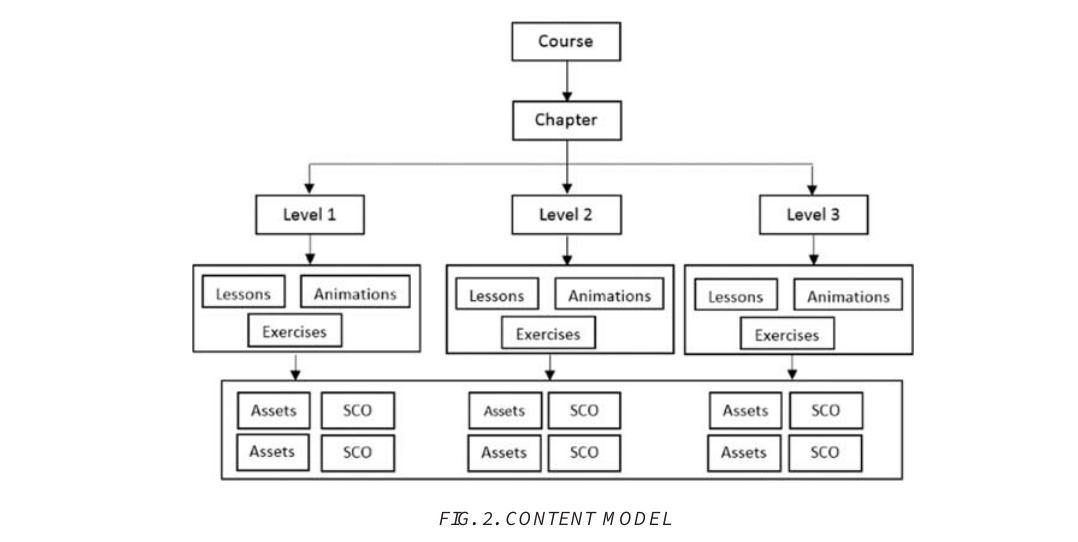
FIG. 1. PROPOSED MODEL OF ADAPTIVE E-LEARNING